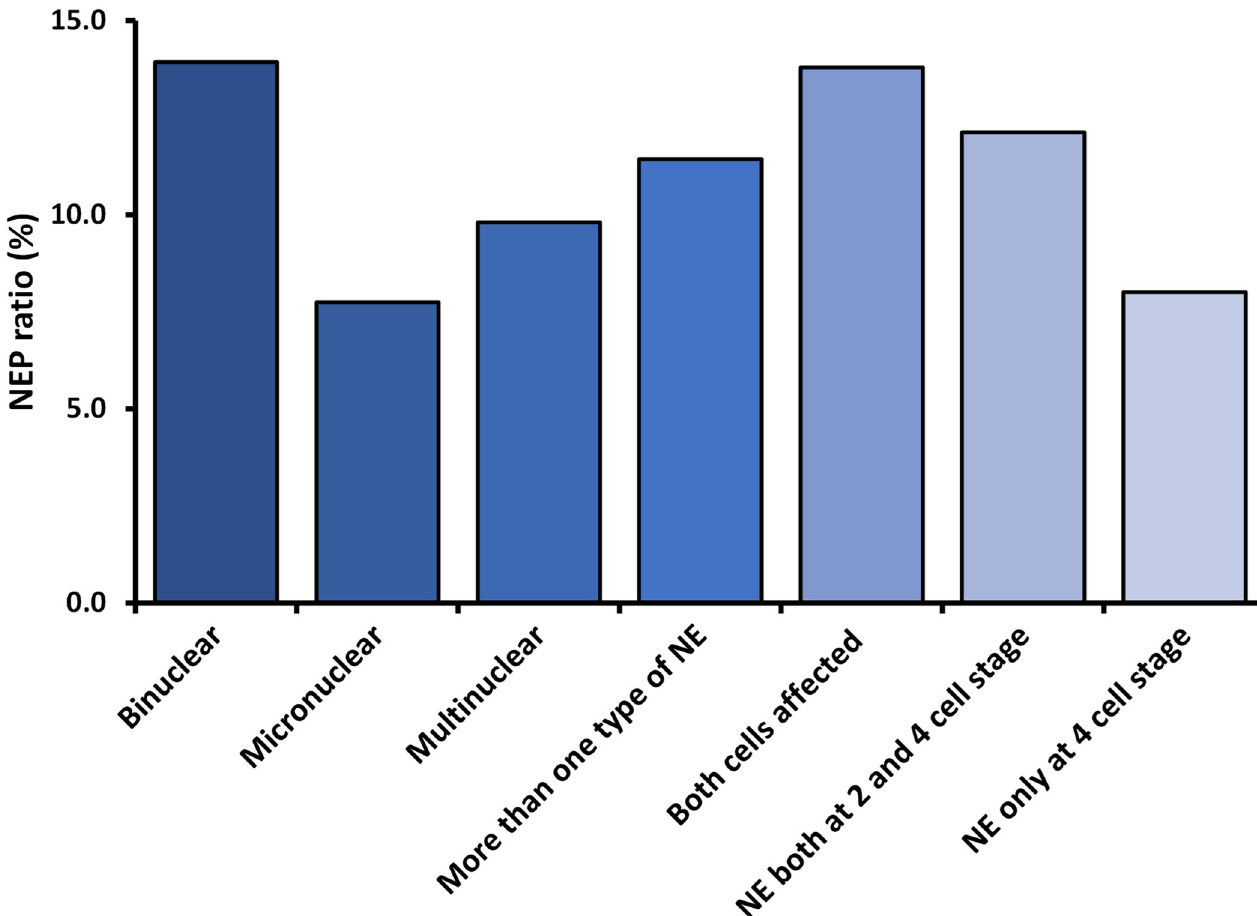
Fig 3. Nucleation error phenotypes (NEP) and effect on Live birth rate (LB-KID).